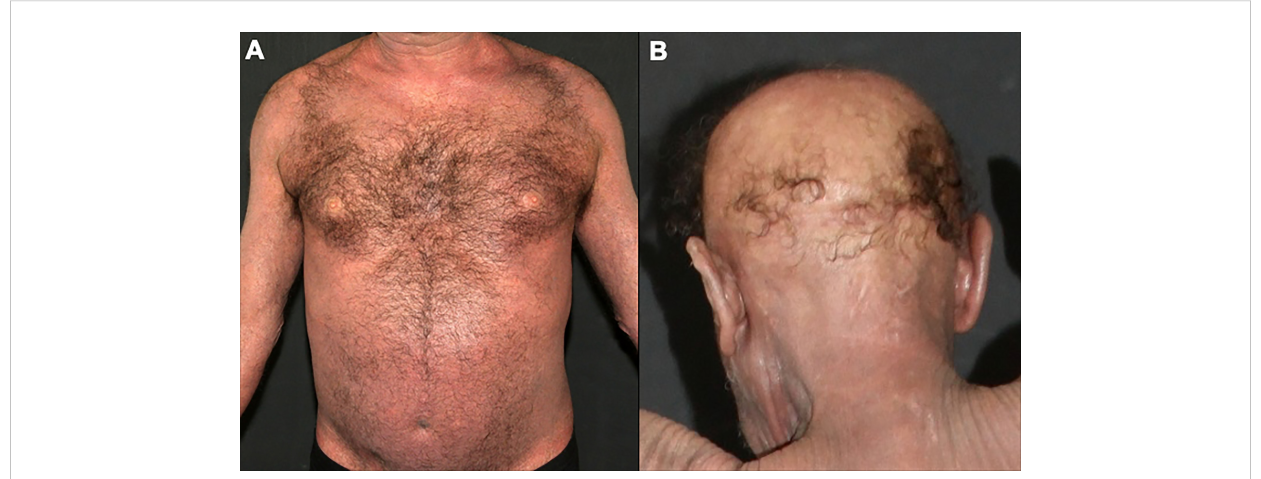
FIGURE 8 Se ́ zary syndrome. Diffuse erythema and scaling (A) and non-scarring alopecia (B)